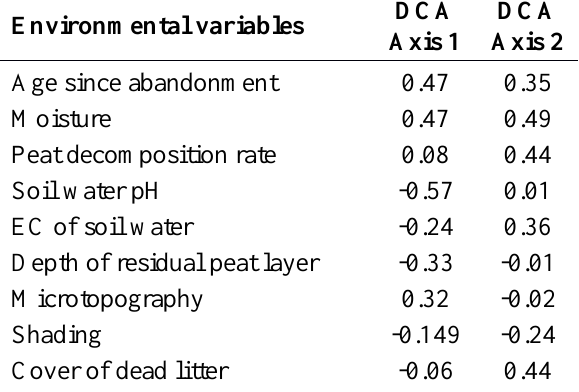
Table 3. Correlation of environmental variables with DCA Axes 1 and 2 (N = 155).